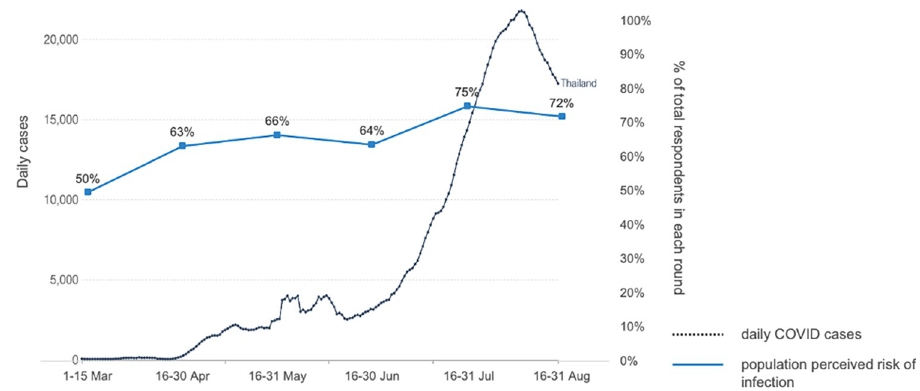
Fig 5. Trend of risk perception and daily cases of COVID-19 in Thailand between March and August 2021.